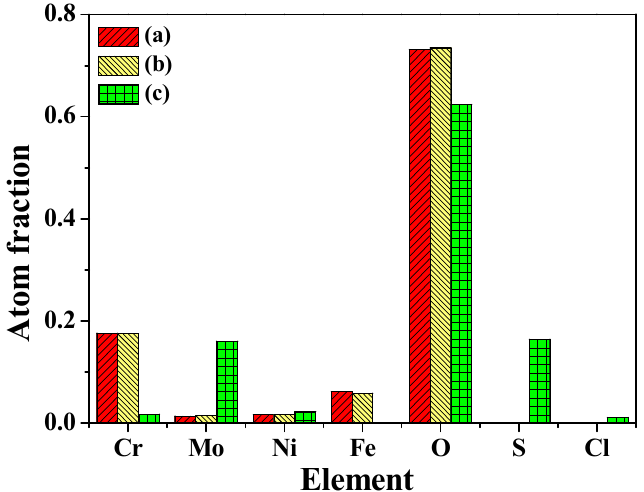
Figure 10. Atom fraction of elements in surficial films of 2205 DSS: ( a ) passive film in 0.137 mol/L HCl solution, ( b ) passive film in 0.137 mol/L HCl + 0.128 Na 2 S solution, ( c ) corrosion product film in 0.137 mol/L HCl + 0.385 Na 2 S solution.